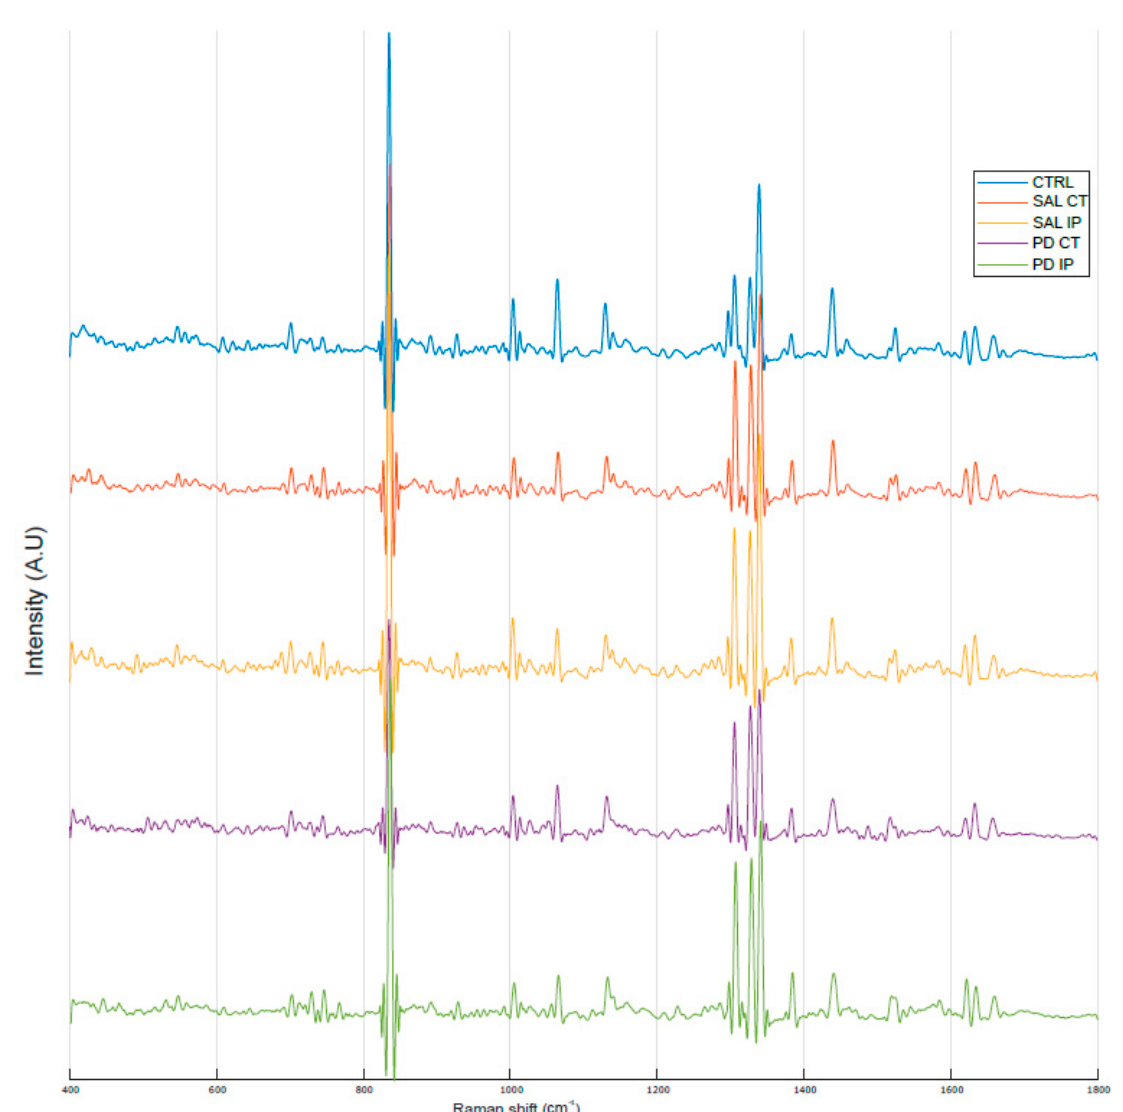
Figure 6. Raman oxidative fingerprint from the average spectra of striatal dECM samples. The spectral interval used for acquisition was from 400 to 1800 cm − 1 . For representation purposes, Matlab software was used to obtain the average smoothed spectra with background subtraction for the striatal decellularized matrices from the control mice (CTRL; total of 57 spectra in blue), saline contralateral hemisphere (SAL CT; total of 48 spectra in orange), saline ipsilateral hemisphere (SAL IP; total of 47 spectra in orange), 6-OHDA-lesioned contralateral hemisphere (PD CT; total of 26 spectra in yellow), and 6-OHDA-lesioned ipsilateral hemisphere (PD IP; total of 42 spectra in